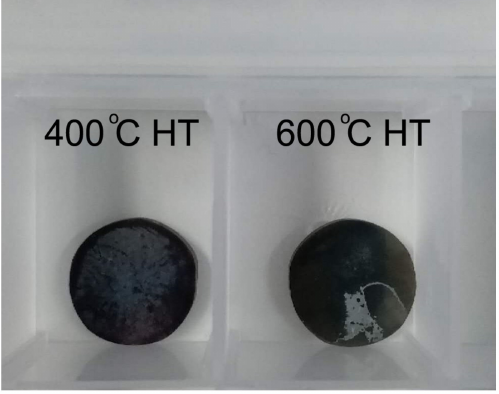
Figure 8. Pieces after ultrasonic vibration testing used to check the stability of